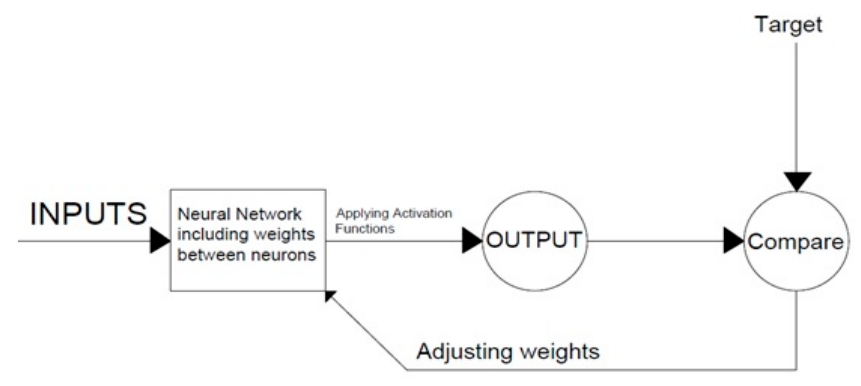
Figure 5. General Structure of the ANN.